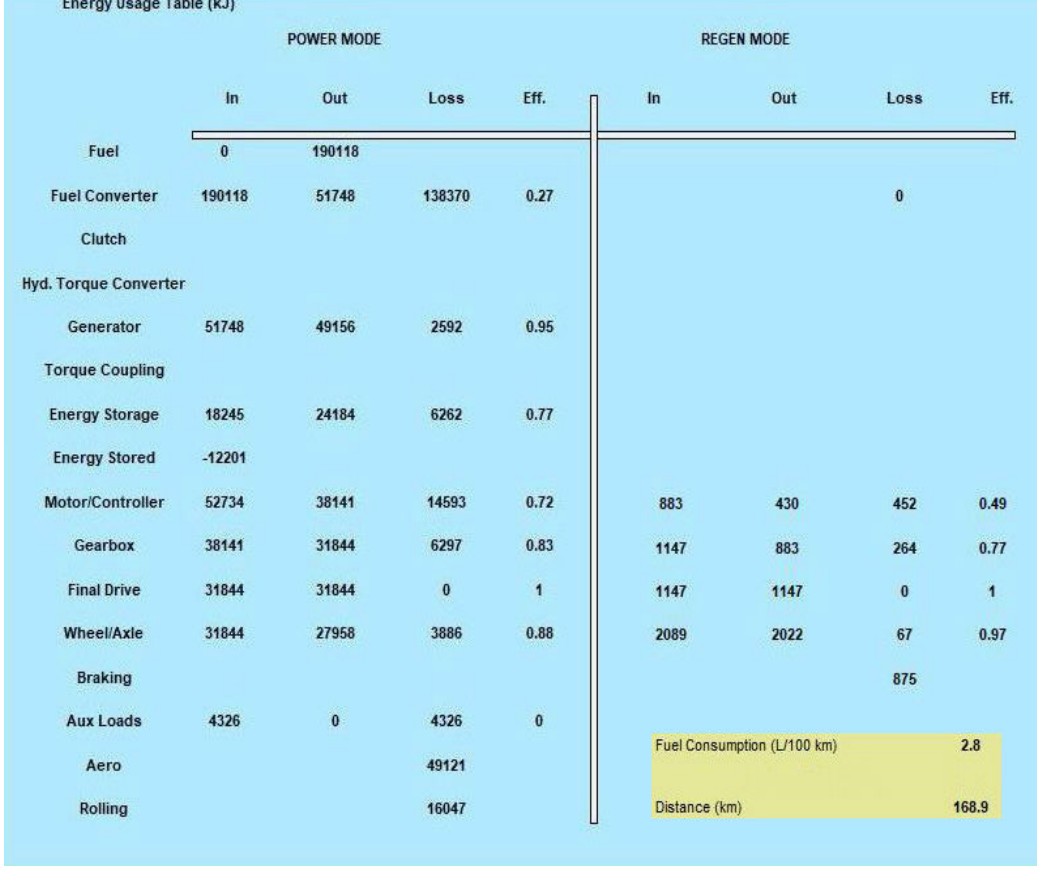
Figure 9. Energy results and fuel consumption for the extra-urban cycle. Table 18. Extra-urban cycle results.